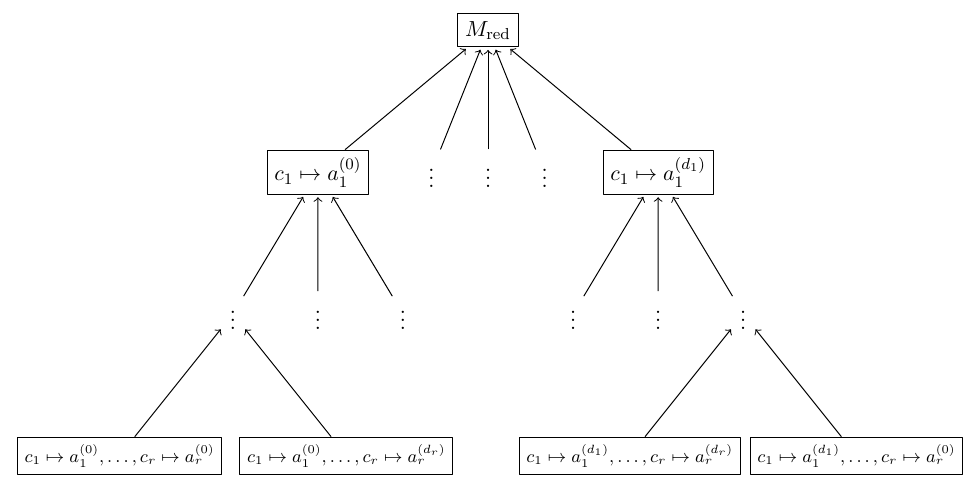
Figure 4 . The structure of the interpolation